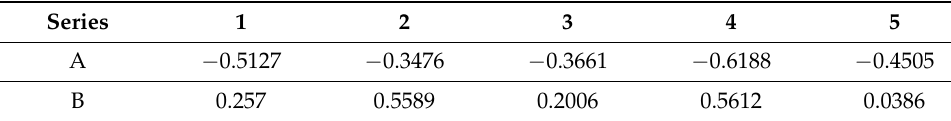
Table 4. Coefficients A and B involved in Equation (9).